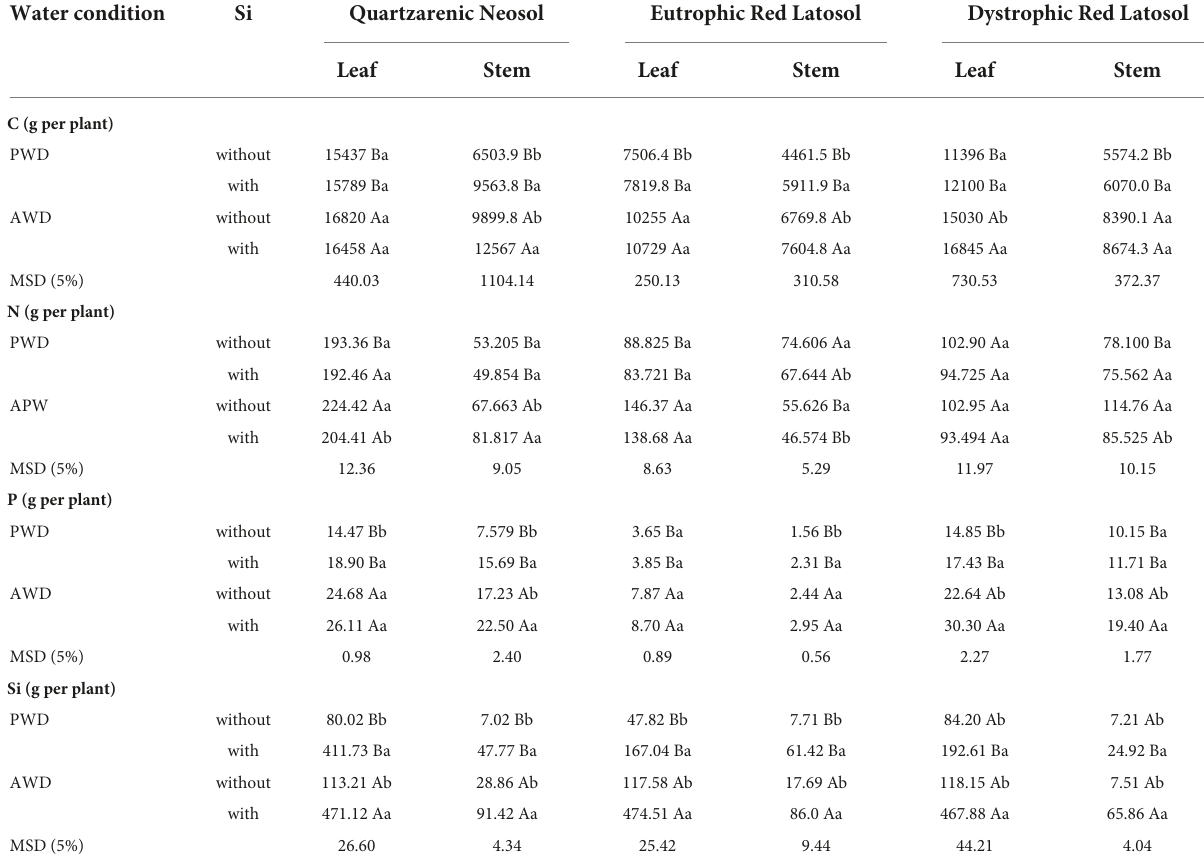
TABLE 3 C, N, P, and Si content in leaves and stems of sugarcane cultivated with absence (0.0 mM) and presence of fertigated Si (1.8 mM) and two water conditions (with and without water deficit) in three tropical soils (Quartzarenic Neosol; Eutroferric Red Latosol; and Dystrophic Red Latosol). Water condition Si Quartzarenic Neosol